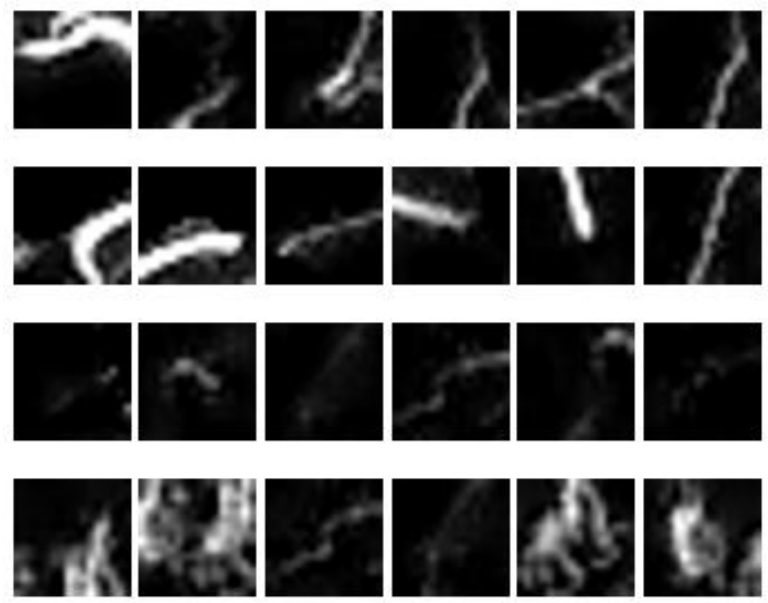
Figure 10. A sample of 24 image patches obtained from 3 MIP